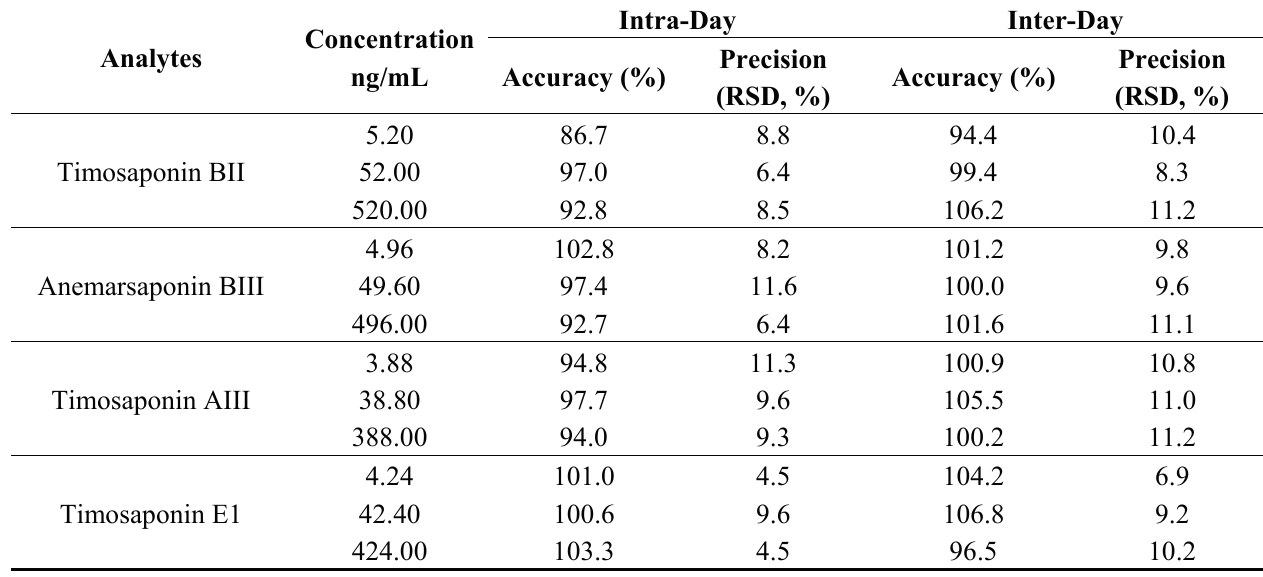
Table 2. The accuracy and intra- and inter- day precision of four analytes in rat plasma ( n = 6).